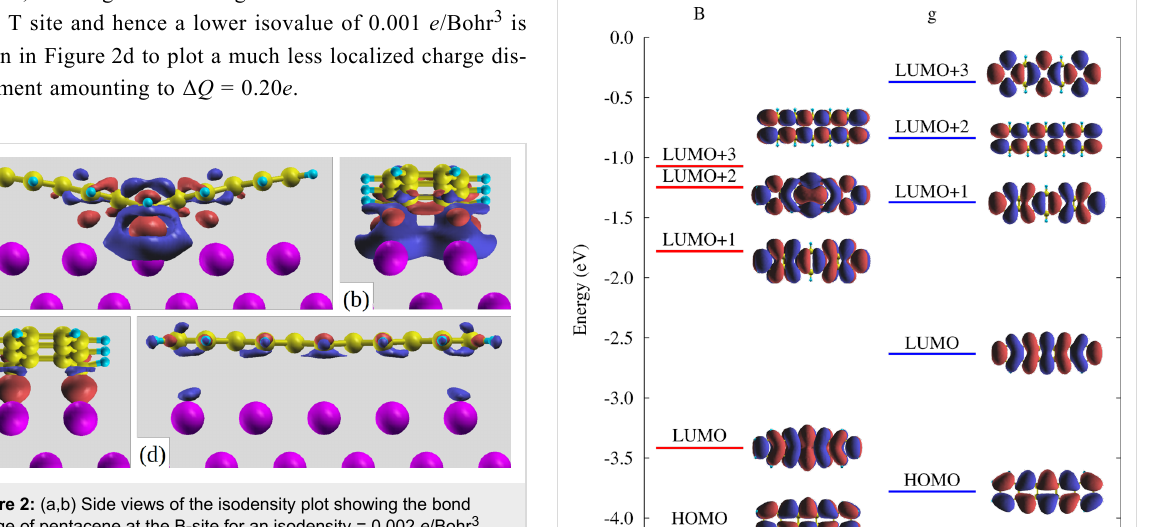
multiplicity of the non-equivalent carbon atoms (see Figure